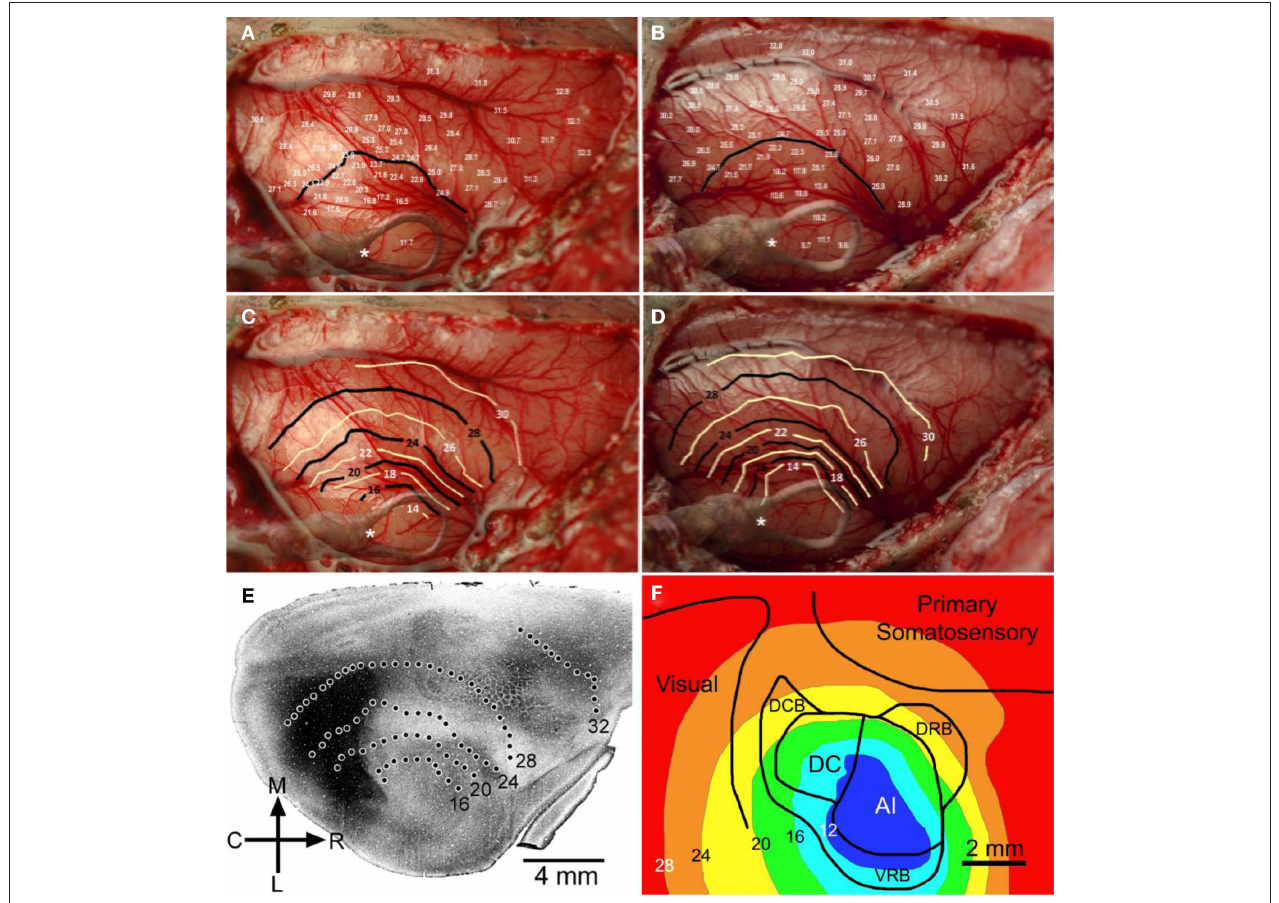
each of these images and the position of the thermocouple monitoring cooling loop temperature was marked (*). (e) Cooling contours from the first GP [shown in (A) and (C) ] were overlaid on an image showing regional boundaries delineated by shading based on cytochrome oxidase staining (from Wallace et al., 2000). (F) Cooling contours from the second GP [shown in (B) and (D) ] were overlaid on a schematic showing boundaries of auditory,